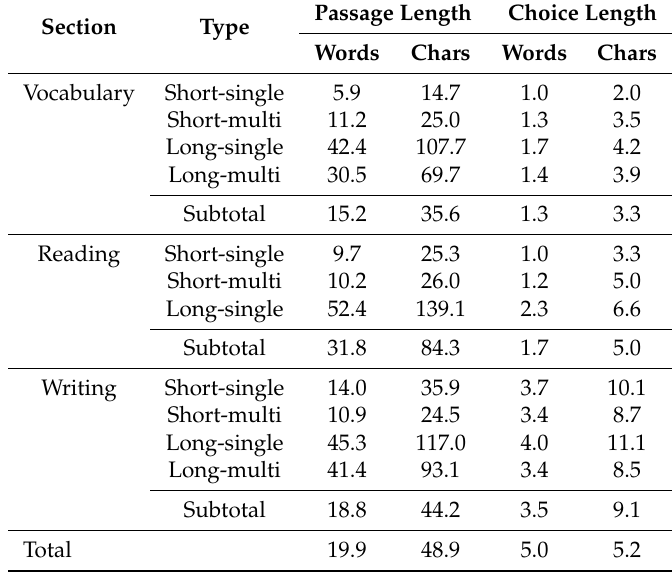
Table 9. Lengths of the cloze-style questions collected from previous TOPIK